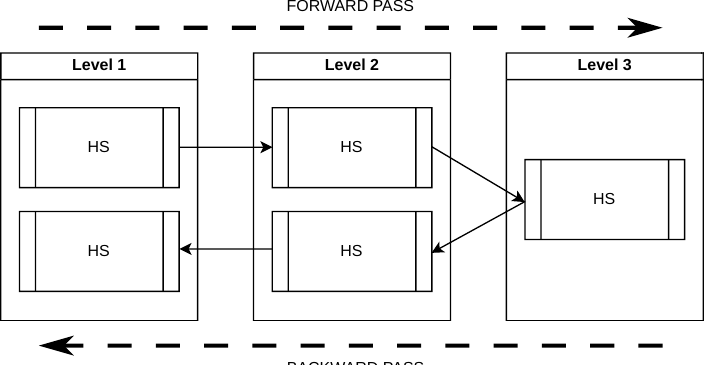
Figure 1. Hierarchical framework made up of multiple hierarchical steps. The complete design is broken down into simpler design problems in the forward pass. The simpler design problems are then solved and reassembled in the backward pass. The directions of the forward and backward passes are represented by the dashed arrows.